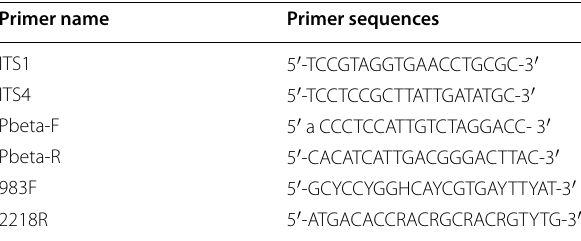
Table 1 Primers of sequences for identifying fungal strains Primer name Primer